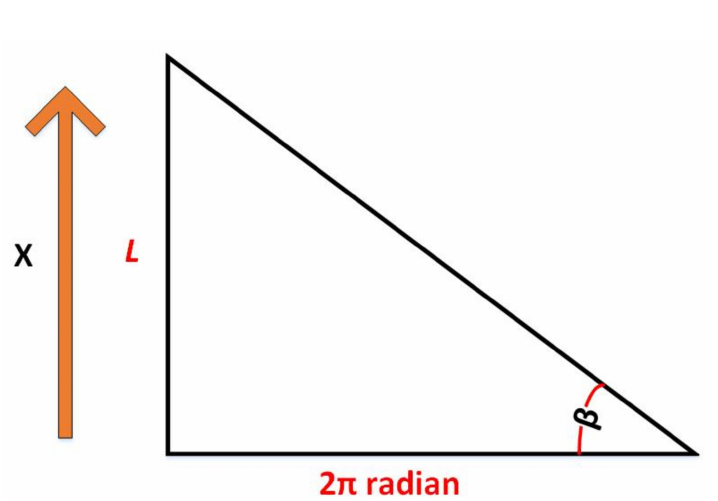
Figure 7. Relationship between angular and linear movement of linear